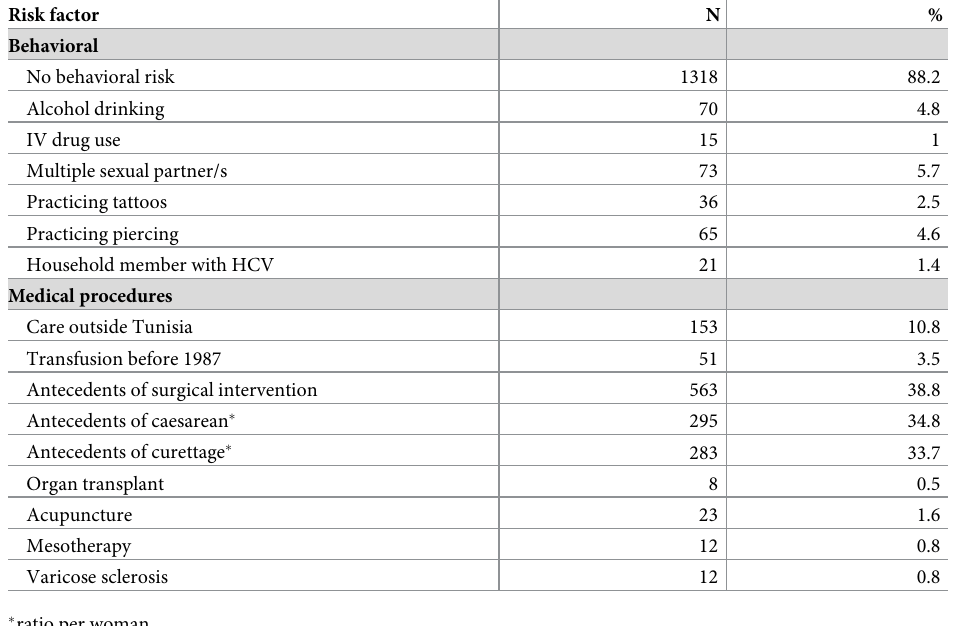
Table 2. Distribution of risky behaviors and history of medical procedures among HCWs (N =